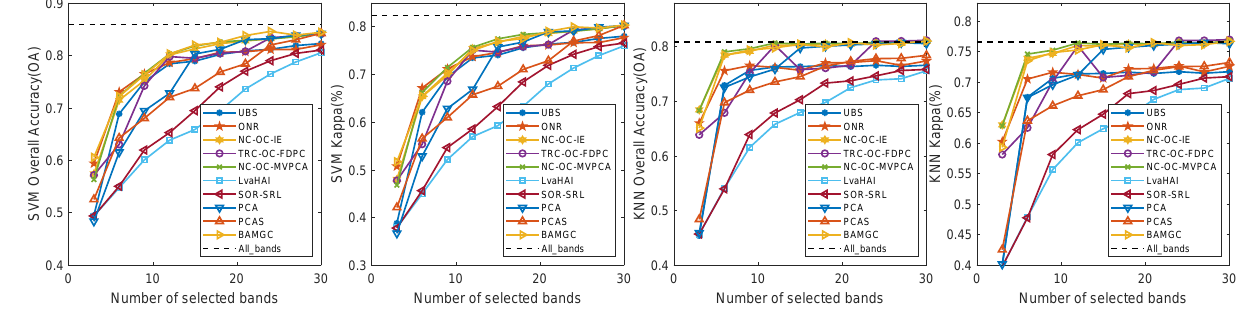
Figure 10. The comparison of OA and κ produced by SVM and KNN on the University of Hous- ton